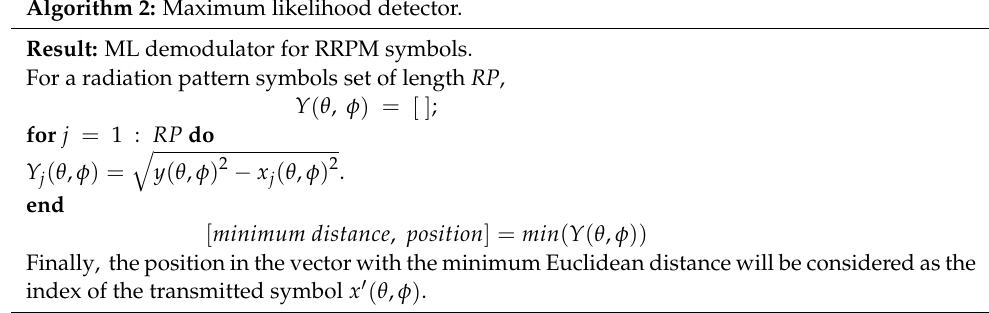
Algorithm 2: Maximum likelihood